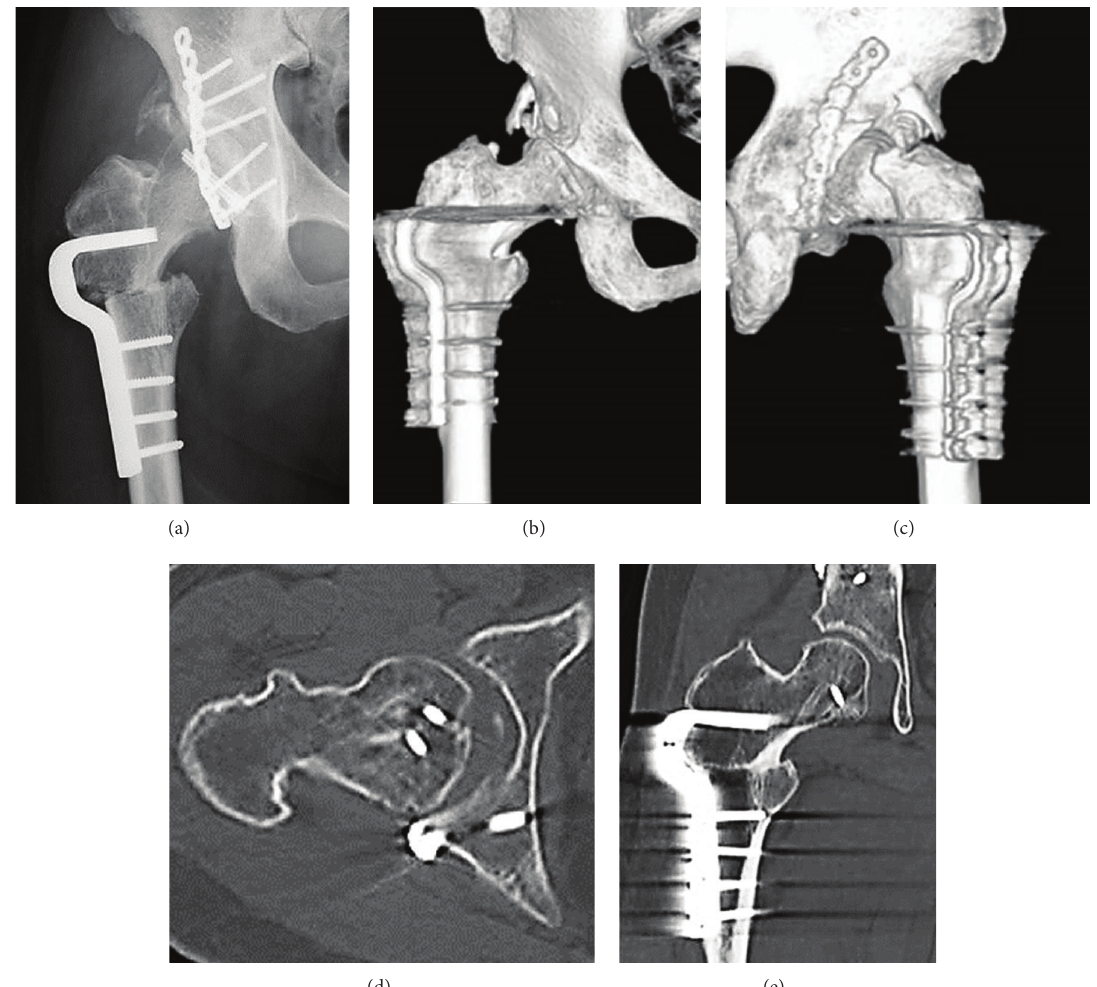
Figure 4: Case 1. (a) Anteroposterior X-ray image of the right hip after a Pauwel intertrochanteric varus osteotomy. (b) Anteroposterior and (c) posteroanterior three-dimensional computed tomography showing derotation of 35 ∘ and varus of 30 ∘ . (d) Axial image and (e) coronal computed tomography showing congruity was improved and internal fixation was